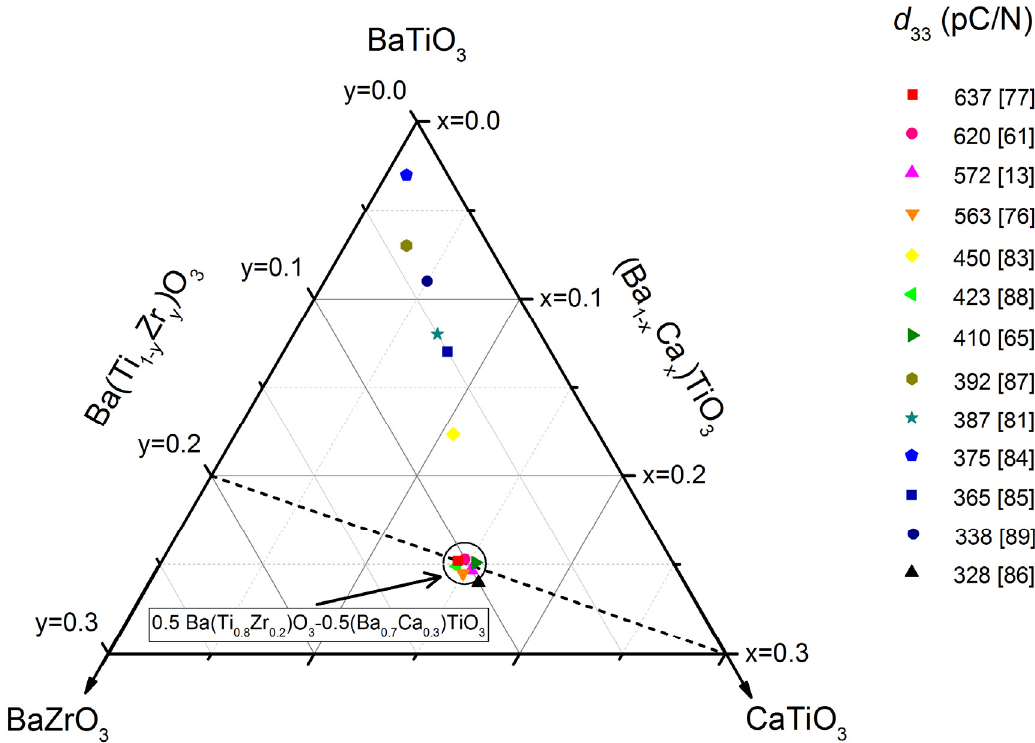
Figure 6. Ternary diagram for the system BaTiO 3 ‐ BaZrO 3 ‐ CaTiO 3 . Piezoelectric d 33 coefficient values for studied compositions are shown. The corresponding references are also shown in brackets.